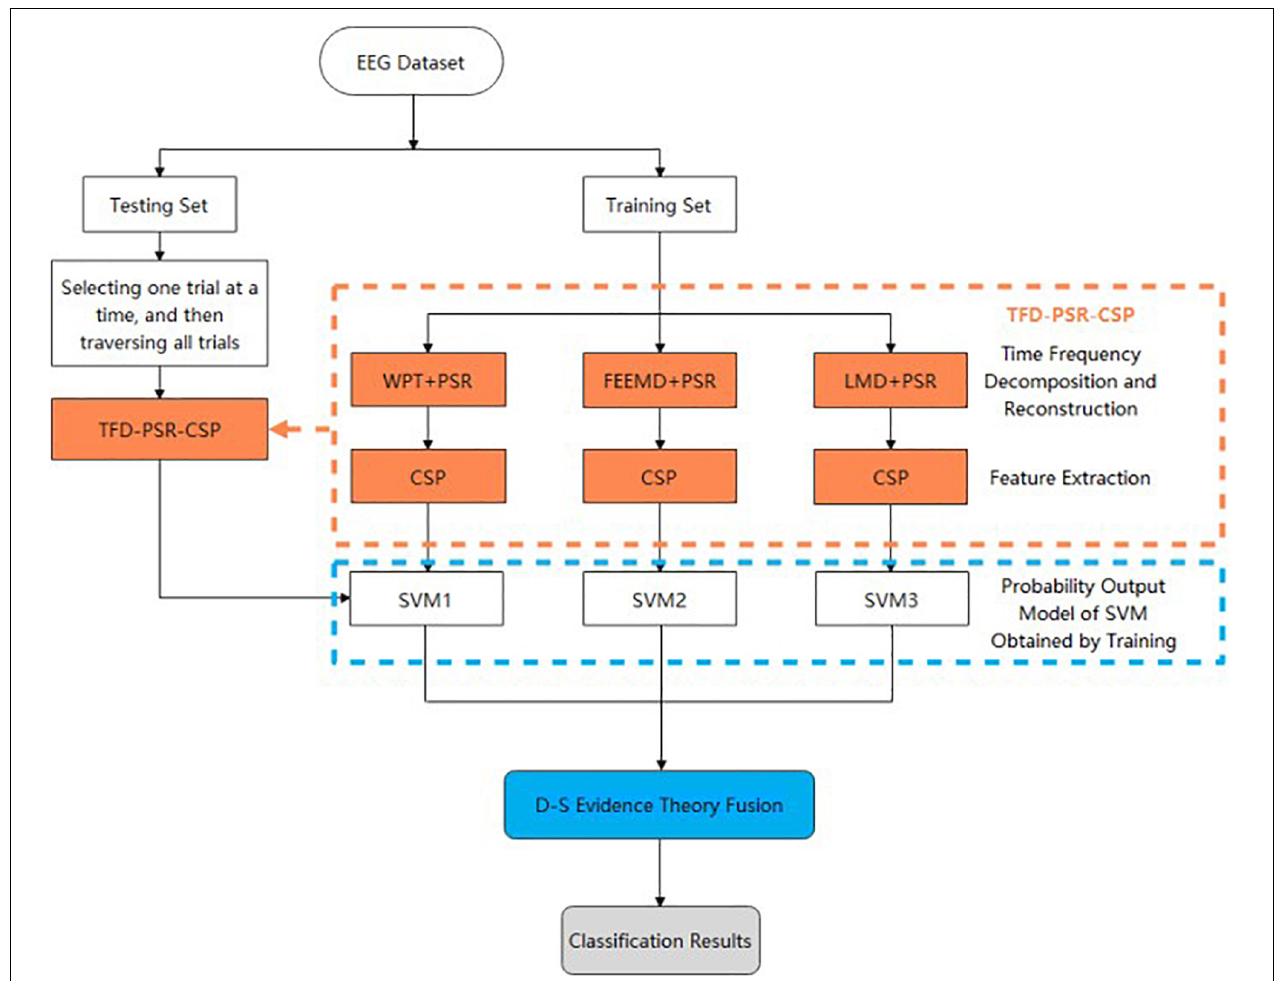
FIGURE 1 | Flowchart of fusion algorithm proposed in this